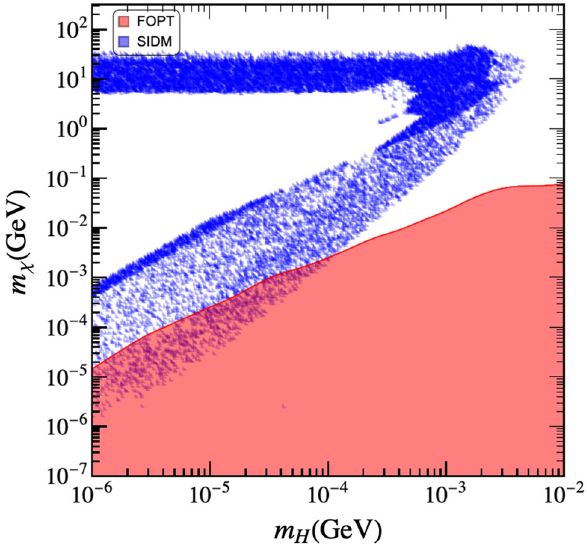
Fig. 2 The blue points are allowed by DM relic density and the small scale structure via SIDM; the red region can give a FOPT